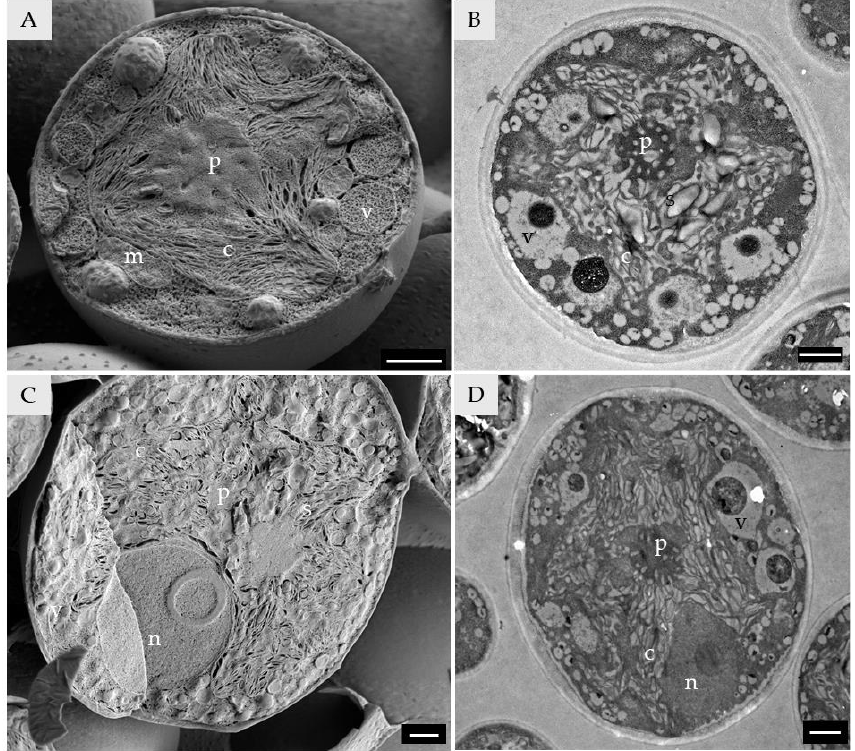
Figure 2. LTSEM ( A , C ) and TEM ( B , D ) of Trebouxia lynnae vegetative cells. ( A , B ) Young vegetative cells. ( C , D ) Mature vegetative cell. Chloroplast (c), pyrenoid (p), vesicles (v), starch grains (s), mitochondria (m), and nucleus (n) are indicated with letters. Scale bars: ( A – D ) 1 µ